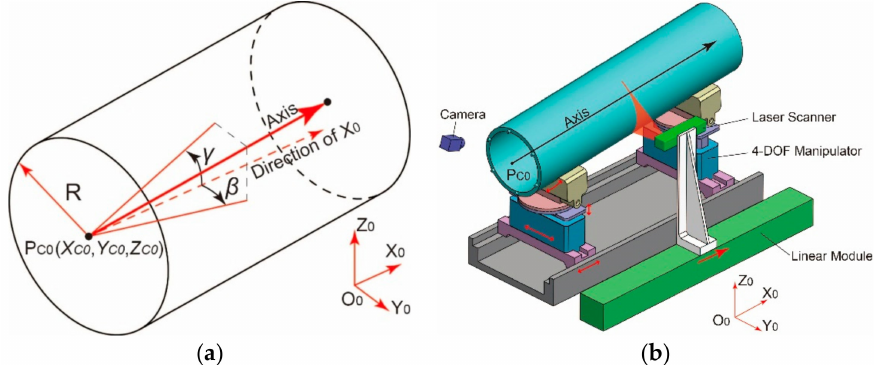
Figure 1. Diagram of the measurement and adjustable support system: ( a ) pose direction of the axis; ( b ) diagram of the structure.